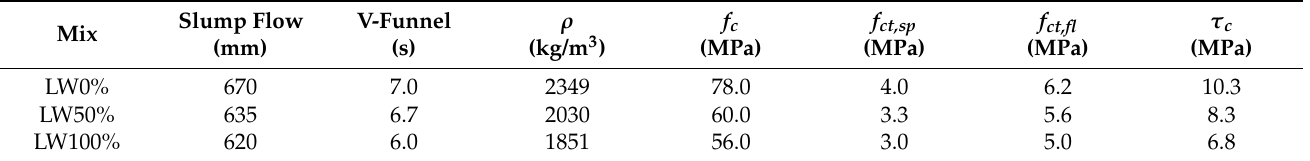
Table 7. Physical–mechanical properties of the tested